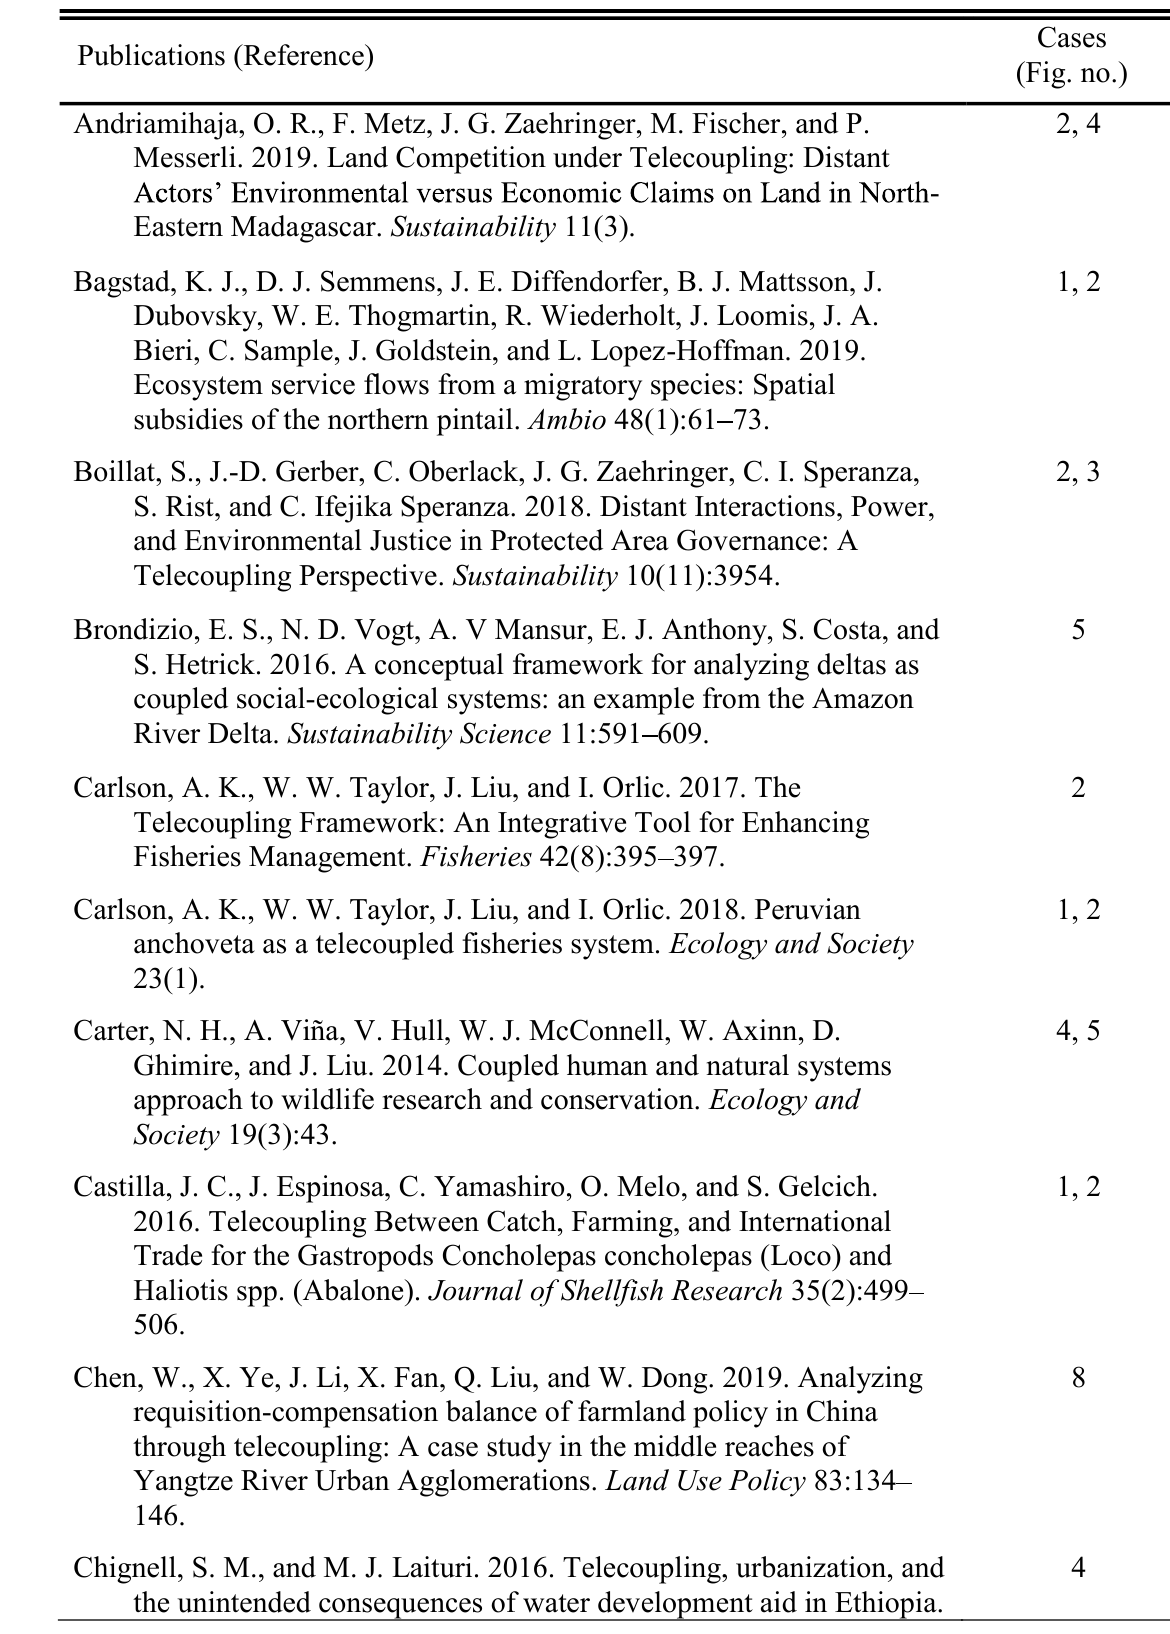
Table A1.1 . List of selected